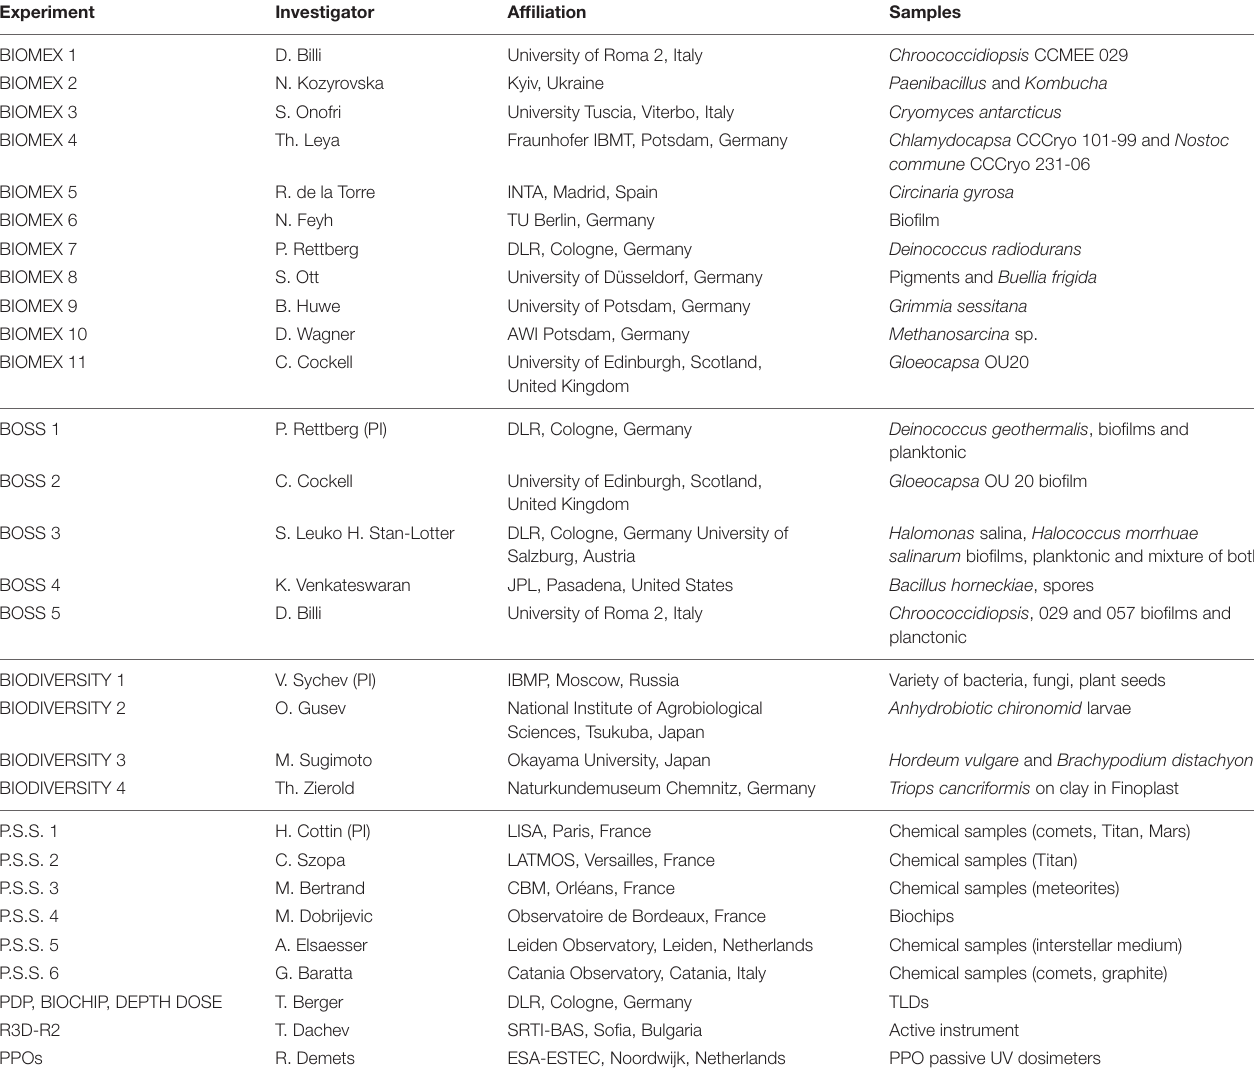
TABLE 1 | List of EXPOSE-R2 experiments, investigators, and samples.